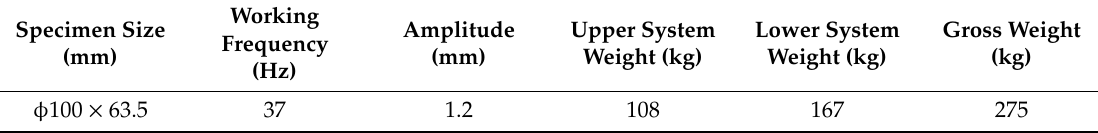
Table 9. Working parameters of the vertical-vibration testing equipment.